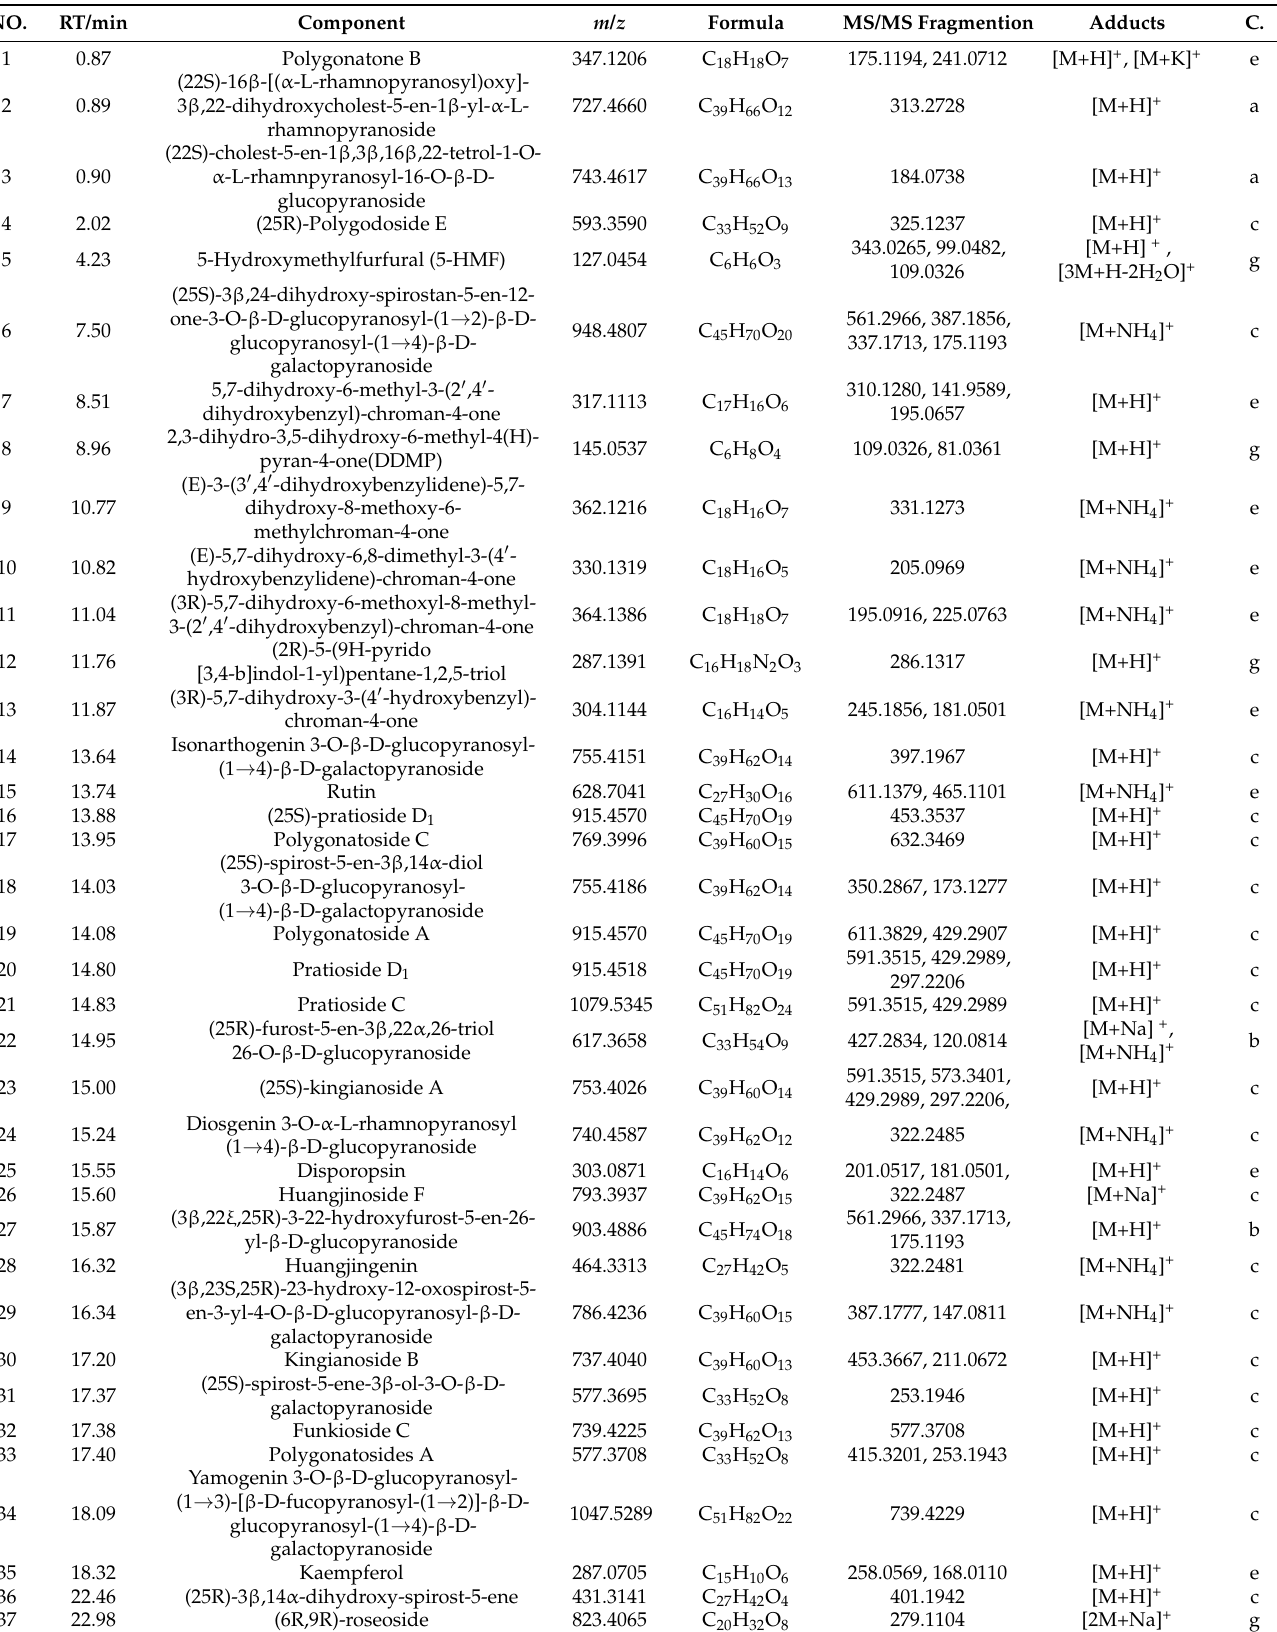
Table 1. Identification of secondary metabolites, monosaccharides, and oligosaccharides in